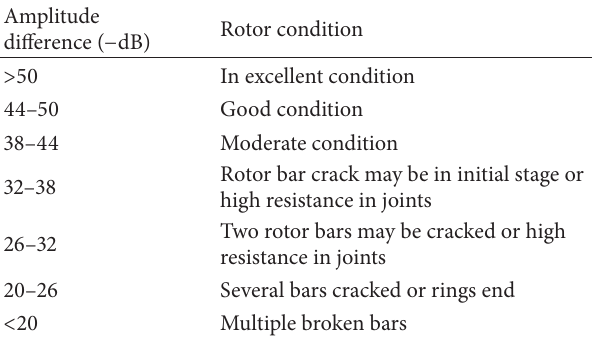
Table 2: Assessing rotor condition